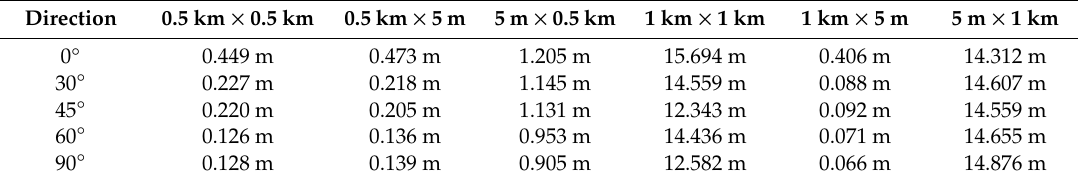
Table 17. The RMS of smoothing layover phase results with di ff erent swell propagation directions (the direction of the smoothing window is in two directions at the same time, in the azimuth and in the